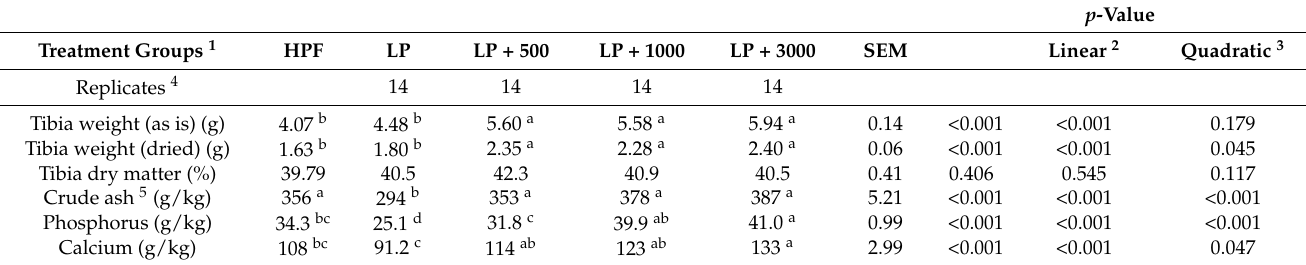
Table 4. Effect of different inclusion levels of phytase on tibia mineralization of broiler chickens at 21 days of